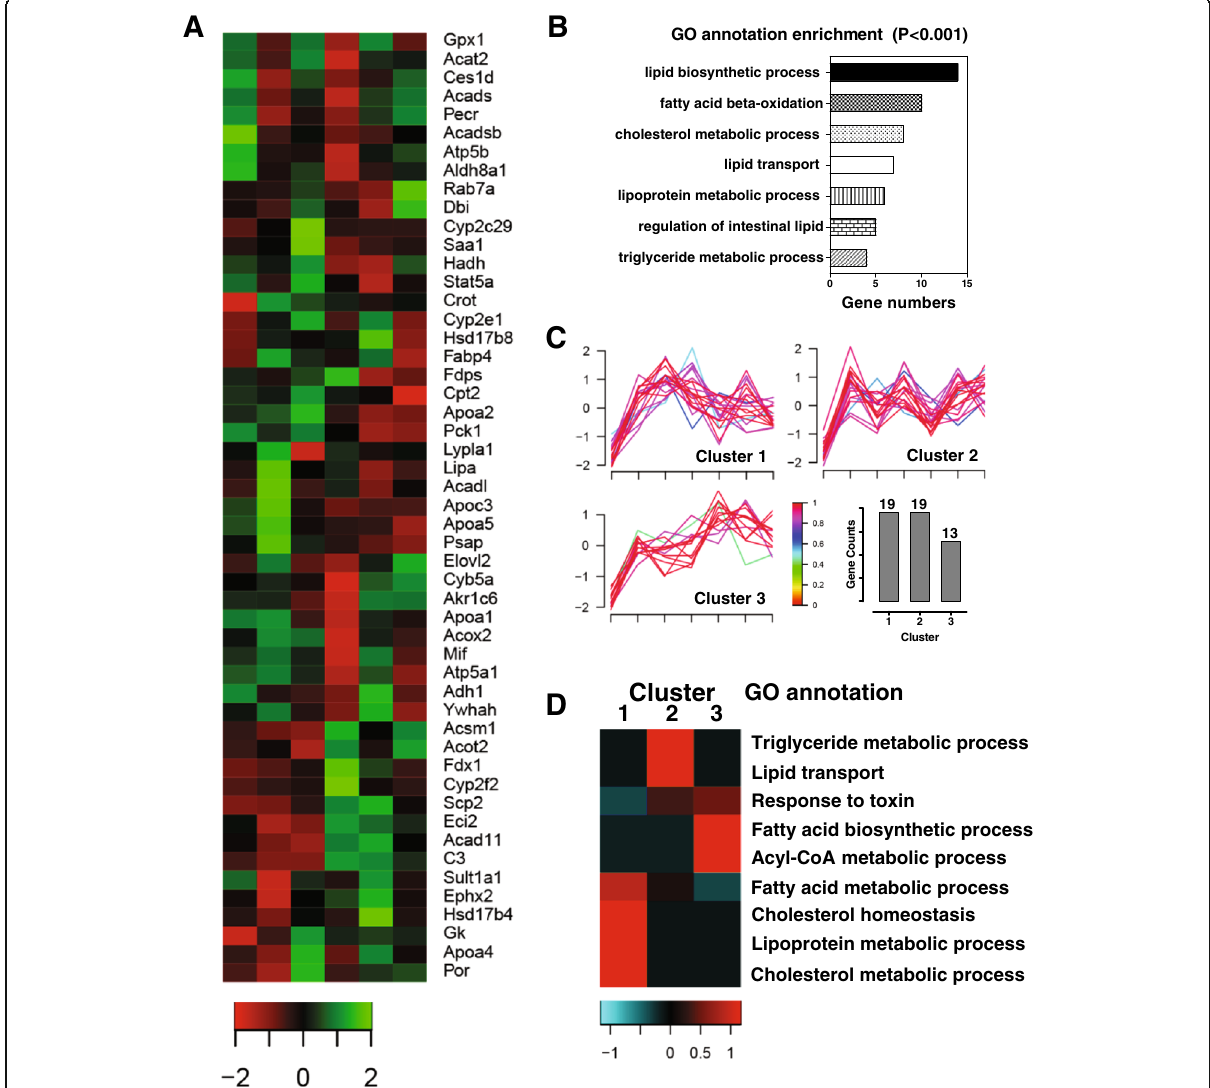
Fig. 5 Cluster analysis of SS-regulated lipid metabolism related proteins. a The list of SS-regulated proteins involved in lipid metabolism. Legend indicates fold changes (Log). b GO annotation enriched biological pathways based on selected proteins. c Cluster analysis and profiles for selected proteins. d Enrichment of GO biological pathways to cluster